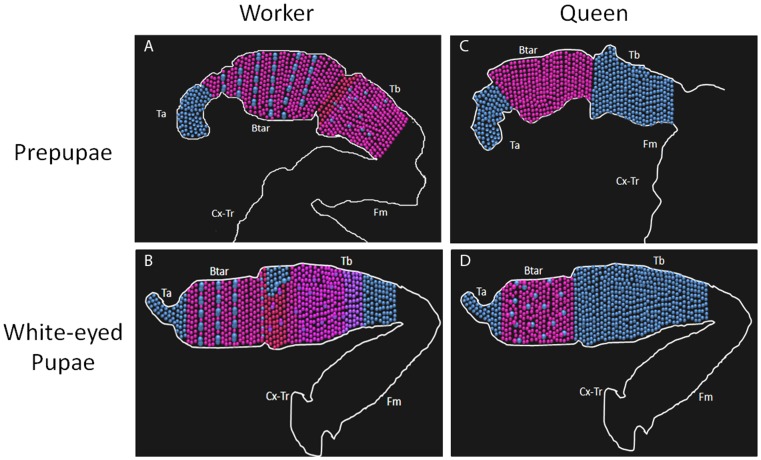
Chart of immunolocalization of Ubx in hind legs of pre-pupae and white-eyed pupae of honeybee castes.
A: pre-pupae workers’ hind leg; B: white-eyed pupae workers’ hind leg; C: pre-pupae queens’ hind leg; D: white-eyed pupae queens’ hind leg. In blue: DAPI; in red: Ubx, note that the different red degrees represent the Ubx level observed in the stainings; Tar: tarsi; Btar: basitarsi; Tb: tibia; Fm: femur; Cx-Tr: coxa and trochanter.